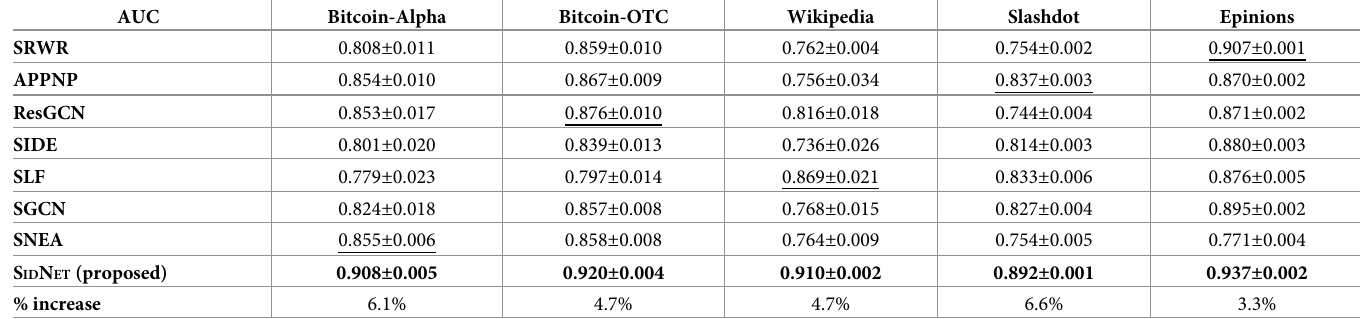
Table 3. S ID N ET gives the best link sign prediction performance in terms of AUC. The best model is in bold, and the second best model is underlined. The % increase measures the best accuracy against the second best accuracy. AUC